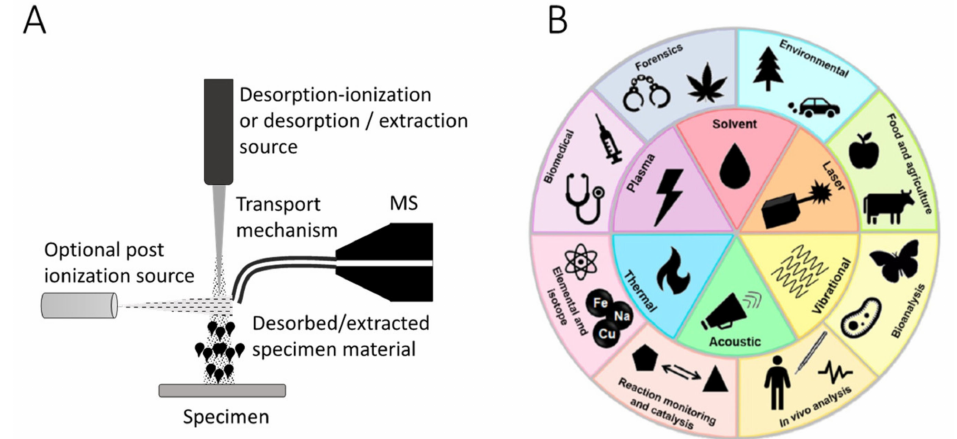
Figure 1. Principles and high-level overview of the mechanisms of ambient mass spectrometry. ( A ) Schematics of a typical ambient MS source. A desorption − ionization source or an extraction source provides desorbed or desorbed and ionized molecules from a specimen under ambient conditions. Inclusion of post ionization is optional and enhances the signal in select cases. A mechanism for the transport of extracted/desorbed materials to the mass analyzer is included that may involve flexible tubing for long (>2 m) transport of surgical aerosols as in iKnife [14], laser desorption plume as in SpiderMass [31] and PIRL-MS [32], or water (as solvent) extracted tissue content as in the MasSpec Pen [17]. The ionization step can take place anywhere between the specimen surface or close to the mass analyzer. A notable difference is lack of chromatographic separation of analytes prior to MS analysis. ( B ) A high-level overview of core ambient desorption/ionization technologies and related applications. Here, a variety of desorption/ionization methods consistent with the schematics provided in panel A are used to generate a multiple application base that ranged from surgical to material to environmental or forensic explorations. Reprinted (adapted) with permission from [3], Copyright 2019 American Chemical